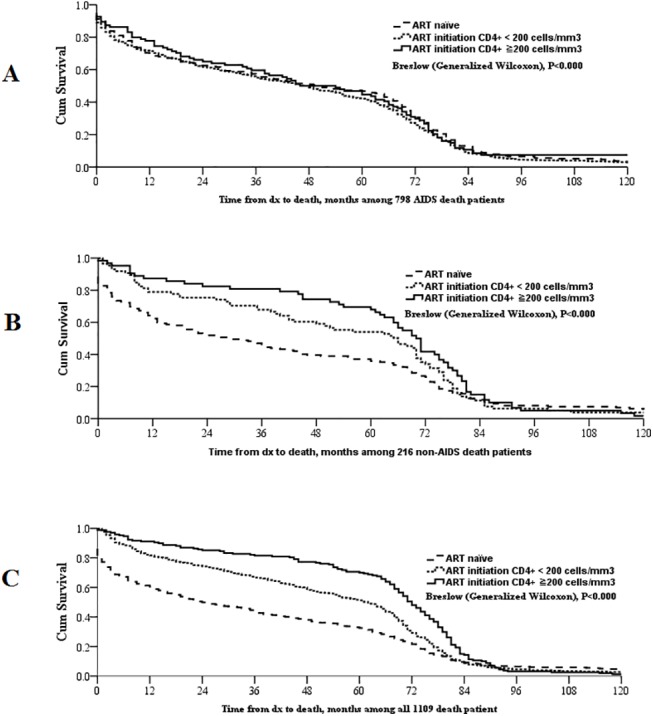
Time from diagnosis to death (months), across different cART groups, by cause of death (AIDS, non-AIDS, all causes).(A) Time from diagnosis to death (months), among 798 AIDS-related deaths; (B) Time from diagnosis to death (months), among 216 non-AIDS related deaths; (C) Time from diagnosis to death (months), among 1109 deceased patients; cART group was divided into ART naïve, ART initiation CD4 <200 cells/mm3 and ART initiation CD4 ≥200 cells/mm3.